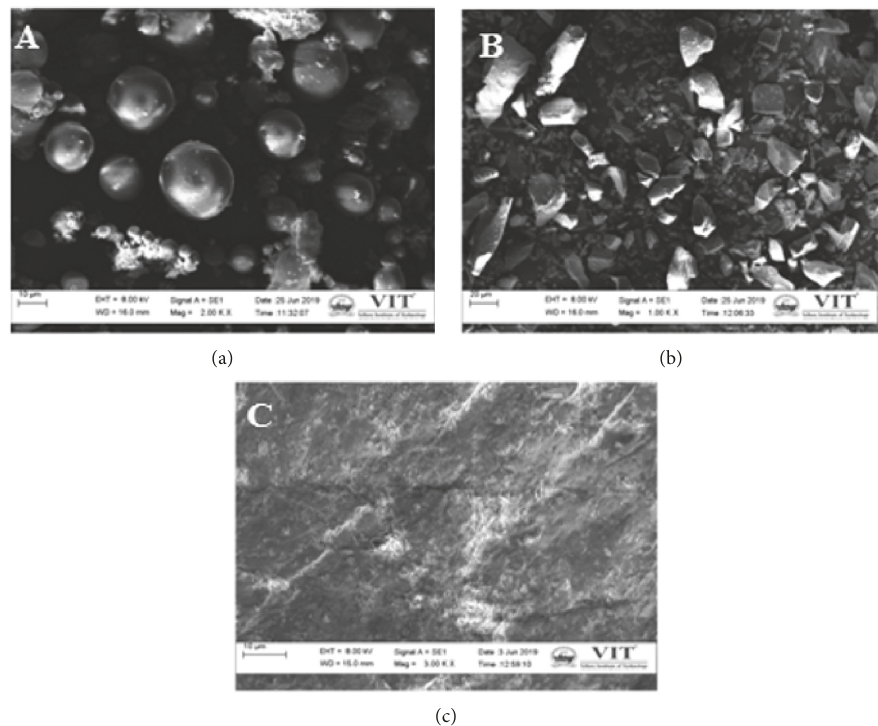
Figure 3: SEM images of (a) fly ash, (b) GGBS, and (c)